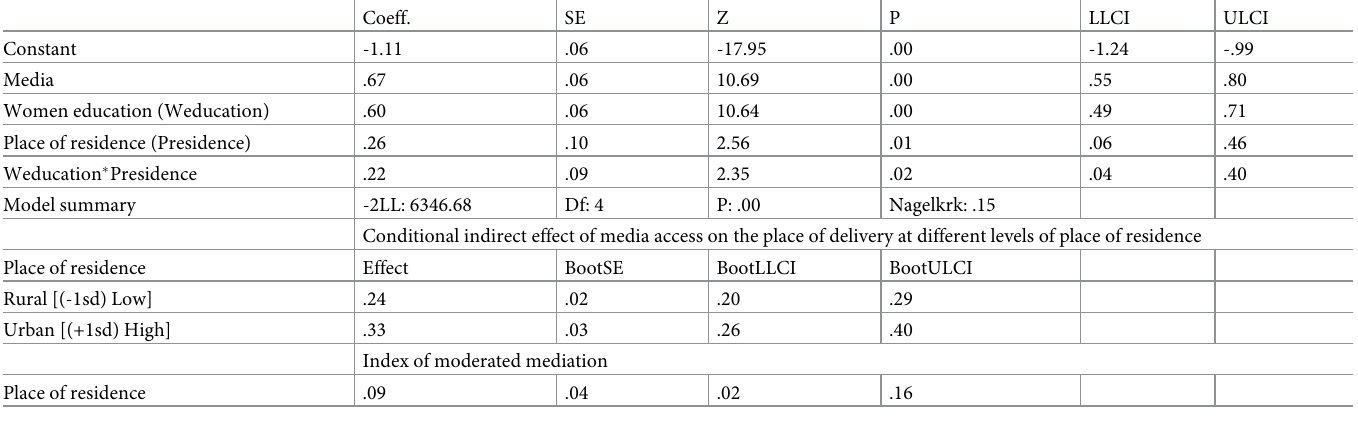
Table 7. Moderated-mediation model 2 (Media women education � area of residence ANC care visits).